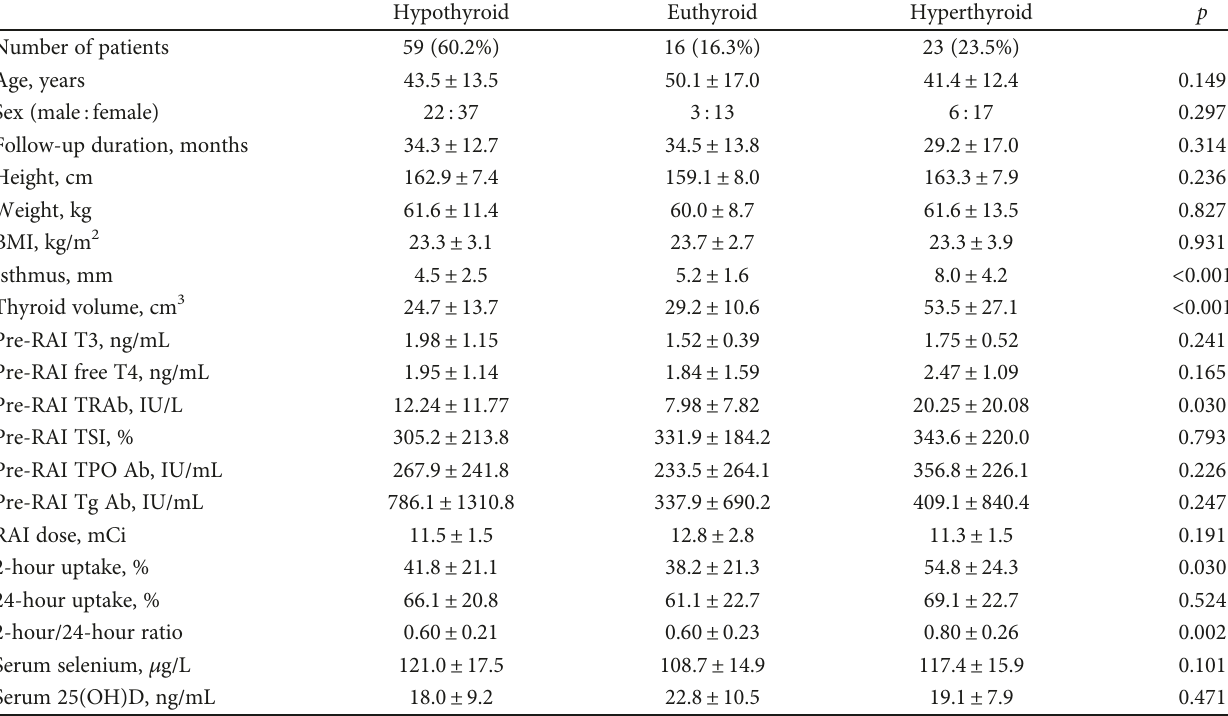
Table 2: Comparison between patients of di ff erent outcome groups after the fi rst RAI